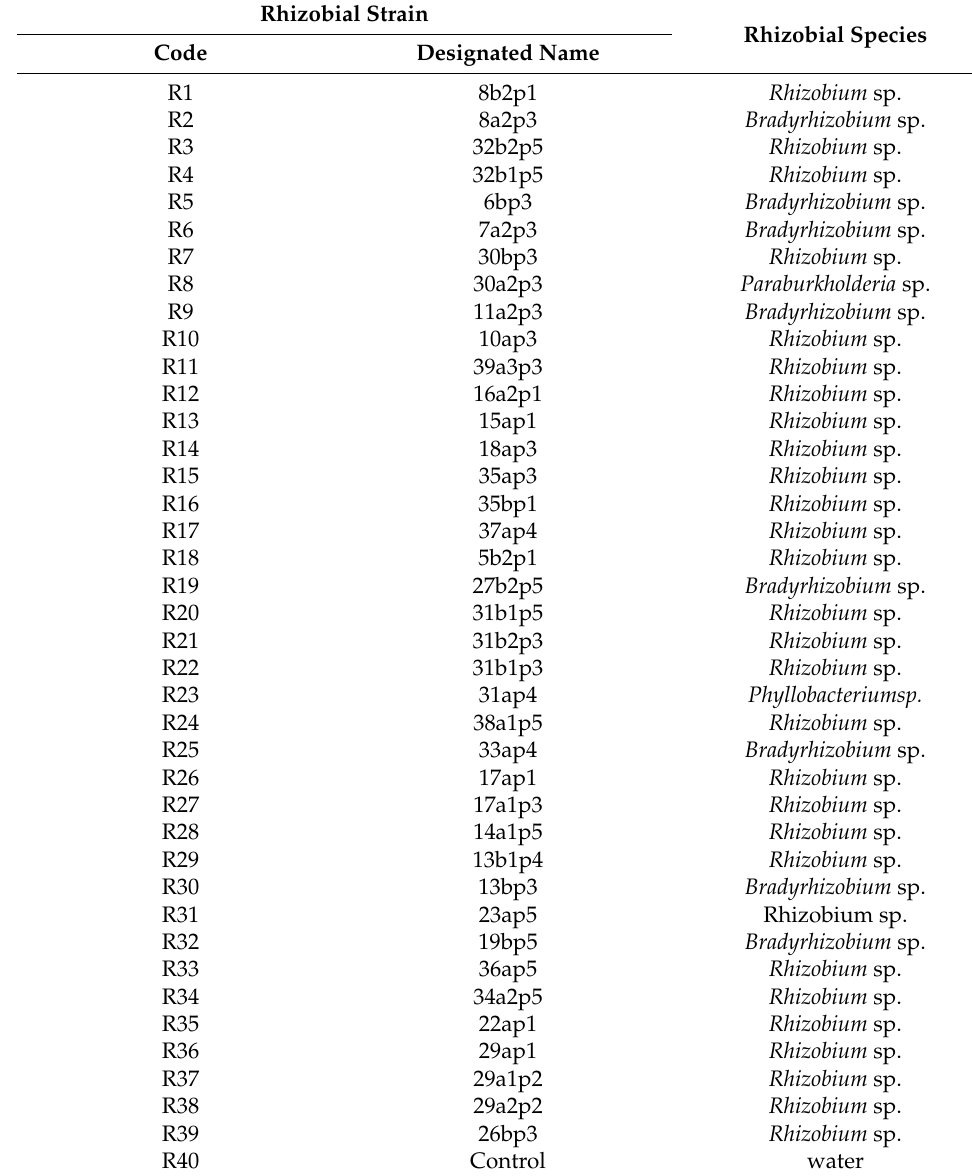
Table 2. Rhizobial strains used in the